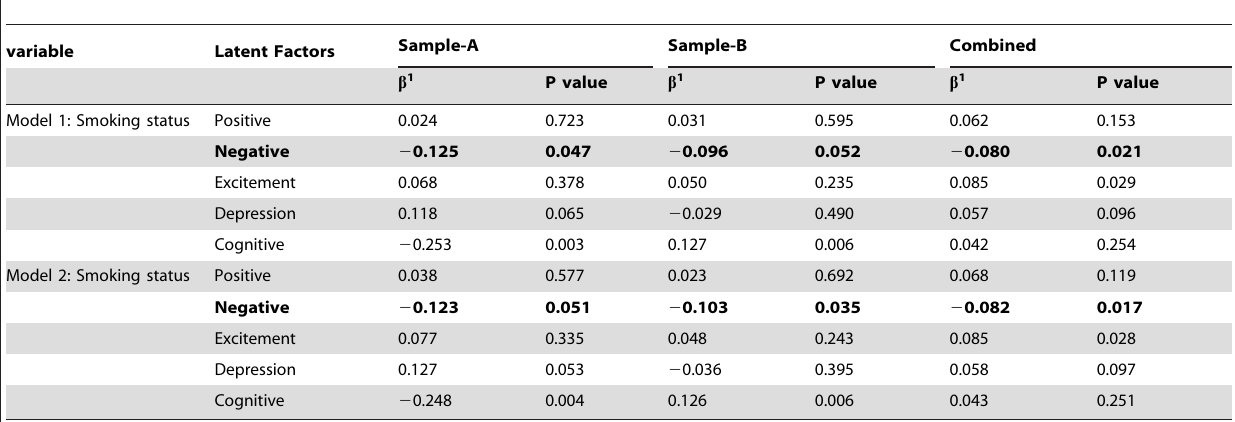
Table 4. Association of smoking with the factors of